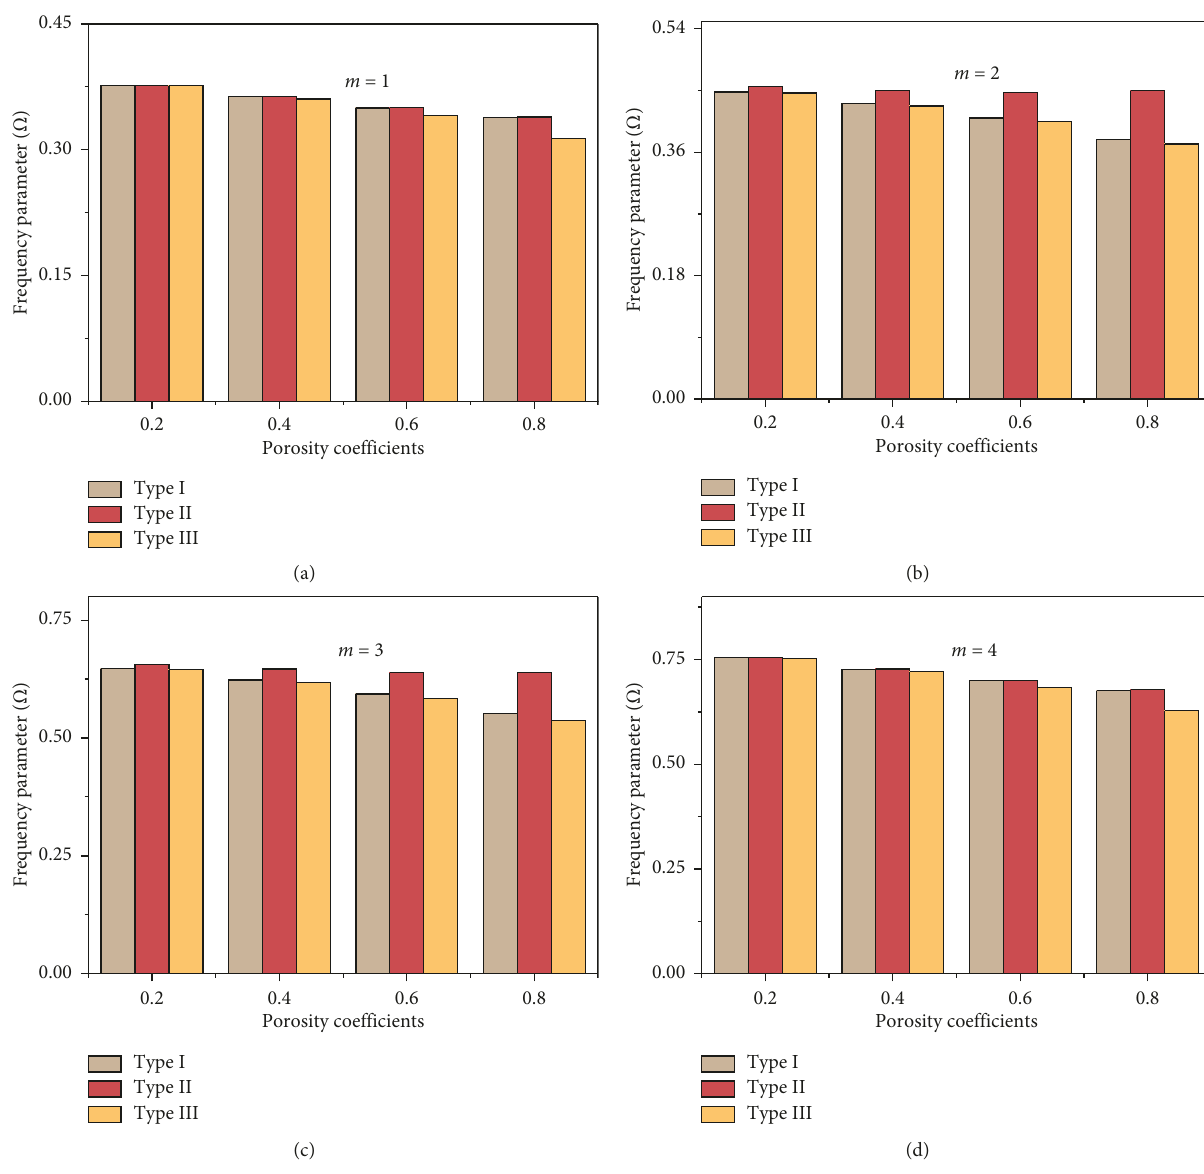
Figure 7: Nondimensional frequency parameter of SSSS porous rectangular plates with different porosity